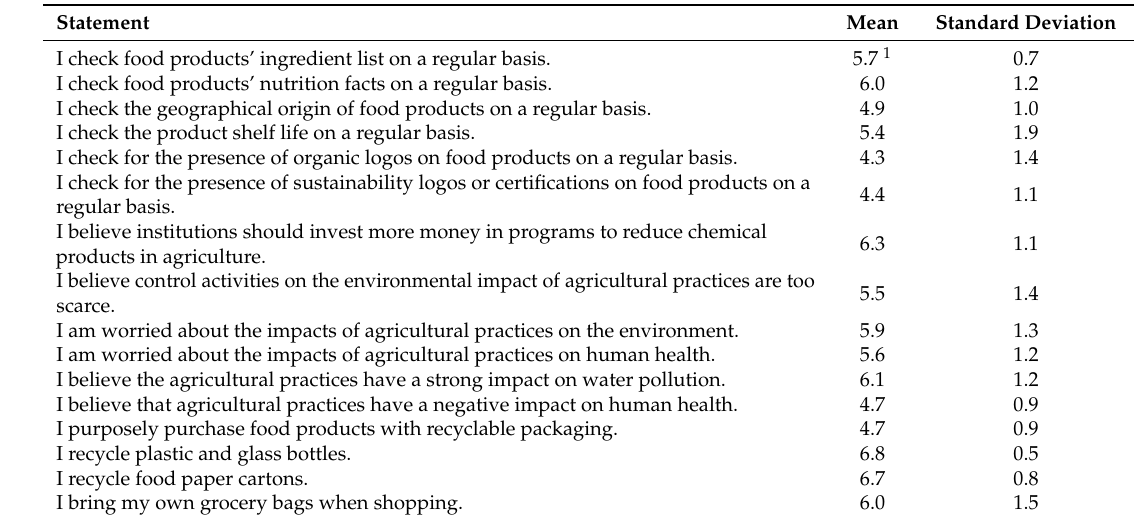
Table3. Meansandstandarddeviationsofparticipants’responses( n = 101)intheconsumeracceptability trial to the questions about their attitudes towards sustainability and food shopping